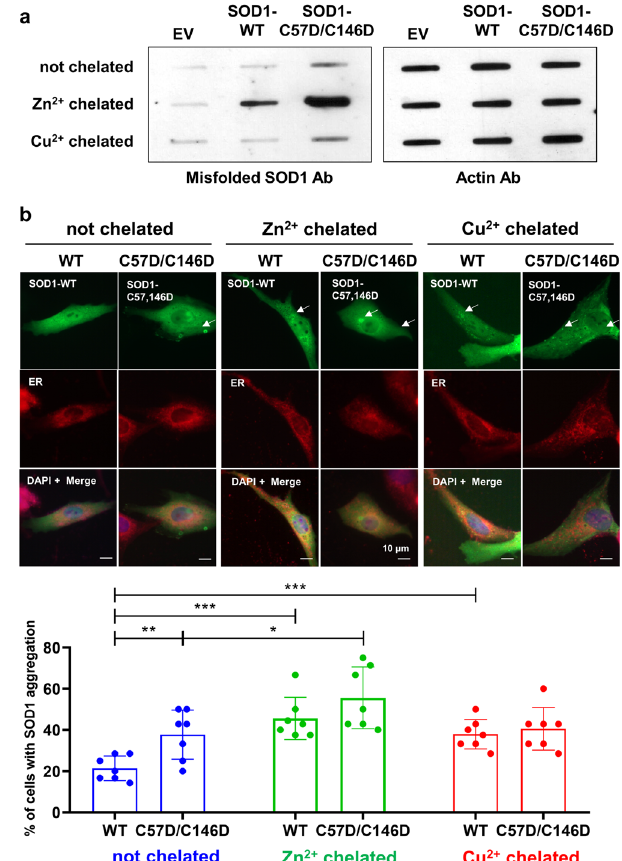
Fig. 2 Cellular inclusions of the ectopically expressed SOD1 proteins in SK-N-SH cells. a The dot blot analysis of the misfolded SOD1 ectopically expressed in SK-N-SH cells. To detect the misfolded SOD1 in the cell lysate, the anti-misfolded SOD1 antibody was used (left). SK-N-SH cells were transfected with pcDNA3.1 plasmid (EV), pcDNA3.1 expressing wild-type SOD1 (SOD1-WT), or pcDNA3.1 expressing C57D/C146D mutant SOD1 (SOD1-C57D/C146D). The Zn 2 + chelator (TPEN) or the Cu 2 + chelator (ATN-224) was treated in the cells during SOD1 transfection. Actin was detected by the actin antibody as a loading control (right). b Top , immuno fl uorescence staining of overexpressed SOD1 in SK-N-SH cells. SK- N-SH cells transfected with pcDNA3.1 expressing the wild-type SOD1 or the C57D/C146D SOD1 gene were incubated with Cu 2 + chelator (ATN-224, right panels) or Zn 2 + chelator (TPEN, middle panels), or without any treatment (left panels) for 12 h. Cells were visualized by the appropriate antibody and dyes: SOD1 in green, ER in red, and DNA in blue. Colocalization of SOD1 with ER shows an orange fi eld. Arrows indicate the cytoplasmic accumulation of SOD1 proteins. White arrows indicated cells with SOD1 inclusions. Scale bar; 10 μ m. Bottom , statistical quanti fi cation of the inclusion positive cells detected by immuno fl uorescence staining. The percentages of inclusion positive cells to the total cells were represented in bar graphs with mean ± SD from seven biological replicates. Statistical comparisons were performed using Student ’ s t -test. Statistical comparisons were performed using Student ’ s t -test. P -value < 0.05 was considered signi fi cant. *, **, *** denote p < 0.05, p < 0.01 and p < 0.001, respectively.